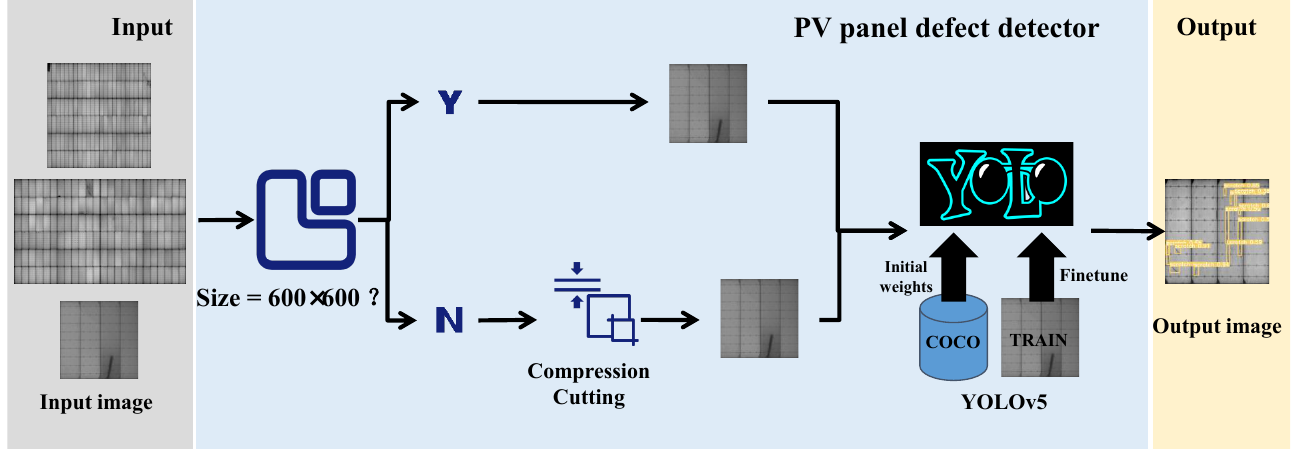
Figure 3. PV panel defect detection